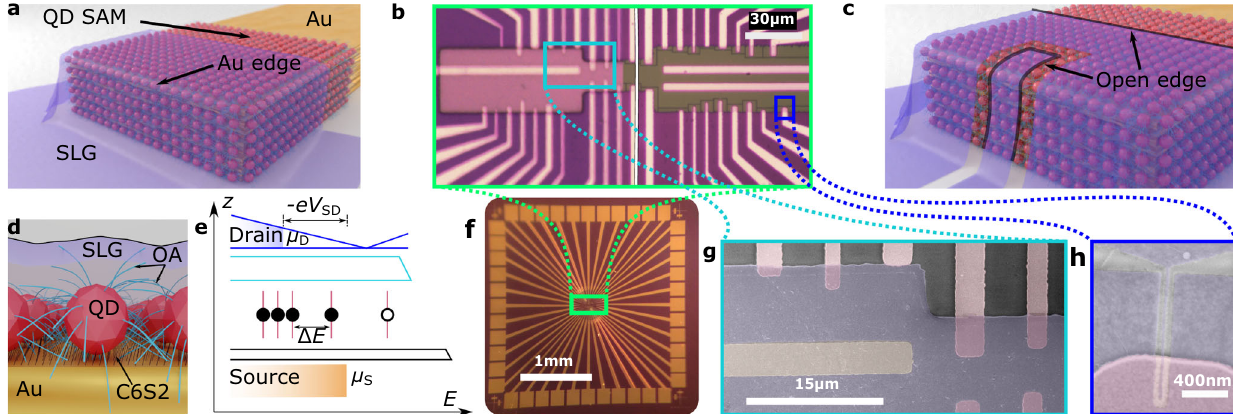
Fig. 1 Device Structure. a Single device: a 1,6-hexanedithiol (C6S2) SAM is bonded to evaporated Au fi ngers, and quantum dots (QDs) capped with oleic acid (OA) are then assembled on the SAM. SLG is draped over the entire structure to form a contacted array of double-barrier junctions in parallel. b Central device region of a single sample containing 39 individually addressable devices with different areas. Devices are created where SLG overlaps the tips of the Au electrodes (vertical lines). The left of the image shows an OL sample and the right an EBL one, where device areas are reduced further by EBL. The central horizontal electrodes are left bare for contacting the SLG. c Computer render of an EBL device showing its open (etched) edge highlighted in the foreground. In the background, the open edge of the original OL device. The open-edge length:area ratio of a device increases when EBL is used to reduce its area. d Single double-barrier structure (centre) as part of a larger array. C6S2 and OA form tunnel barriers between the QD and Au and SLG, respectively. e Energy structure of a junction aligned with the picture in ( d ). The Au and SLG electrodes are the source and drain, respectively. The C6S2 SAM and the QD ’ s OA ligands form tunnel barriers at the Au/QD and QD/SLG interfaces, respectively. The QD has a discrete energy spectrum due to its addition energy E C = e 2 /2 C , where C is the QD ’ s capacitance, and its single-electron energy levels. In this example a negative source-drain bias V SD is applied across the junction. This determines the energy window directing the transport by altering the electrodes' electrochemical potentials. The available energy − eV SD has just increased enough to allow a second electron to reside in the QD. The electrons do not tunnel out quickly as the exit barrier is thicker than the entrance one, but the total probability of leaving becomes twice what it was with one electron, and hence the tunnelling current steps up by about a factor of two. Addition of extra electrons (or holes) like this is exhibited as steps in the I − V characteristic, dubbed a Coulomb staircase. f Single sample showing each device in the central region as individually addressable via bond pads on its perimeter. g False-colour SEM image of 7 OL devices (electrodes shown vertically in pink), each with a different area (0.34 ± 0.22 − 11.9 ± 1.2 μ m 2 ) arising as a result of the electrodes' relative positions spanning the optical-lithography alignment accuracy of the SLG patterning (shown in blue). A horizontal grounding electrode with no SAM is seen at the left of the image in yellow. h False-colour SEM of single EBL device (like that in c ) with area 11500 ± 2300 nm 2